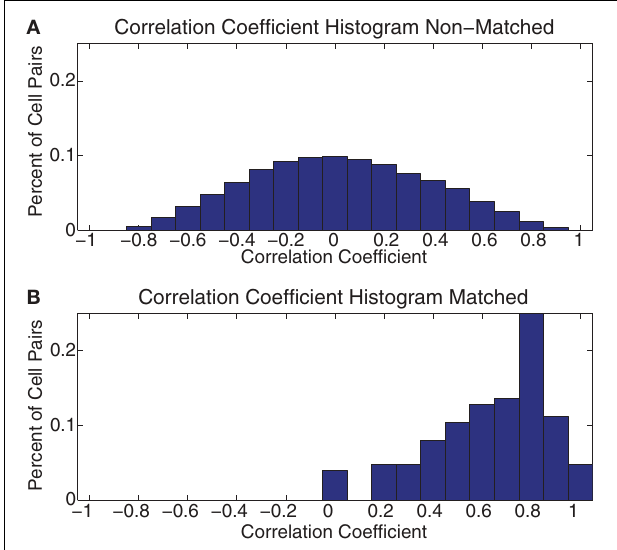
FIGURE 12 | Histogram of across-day correlations. (A) Histogram of the correlation coefficient of all pairs of the 7 × 7 grids of FR seen in Figure 11 for all pairs of cells not identified as being the same cell recorded across multiple days (Non–Matched). (B) The same histogram as in part (A) but for all pairs identified as being the same cell on consecutive days (Matched).